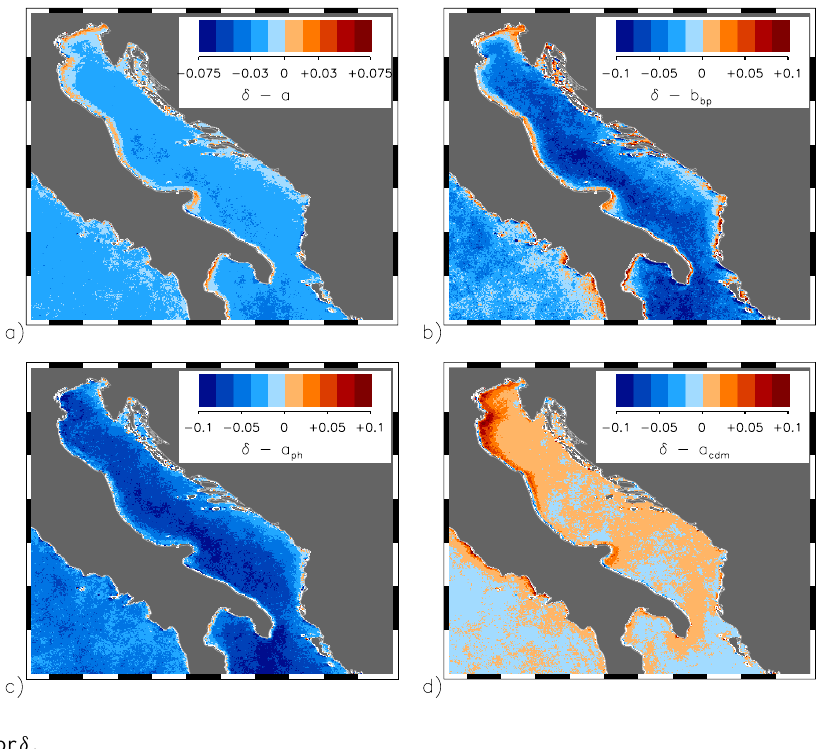
Fig. 5. Same as Fig. 4 for δ .